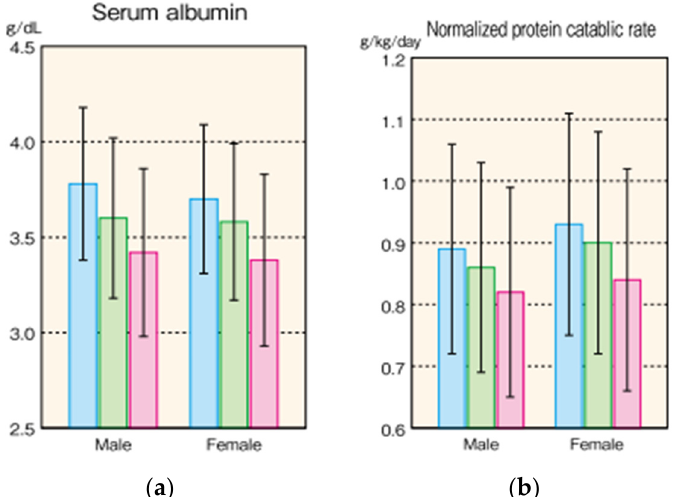
Figure 1. Nutritional status in Japanese HD patients in 2015. (Masakane, I. et al. [10]). ( a ) Serum albumin level ( b ) Normalized protein catabolic rate, of Japanese HD patients. Data are expressed as Mean ± SD. Blue column expresses patients below 60 years old, green column 60–74 years old, and red column over 75 years old.